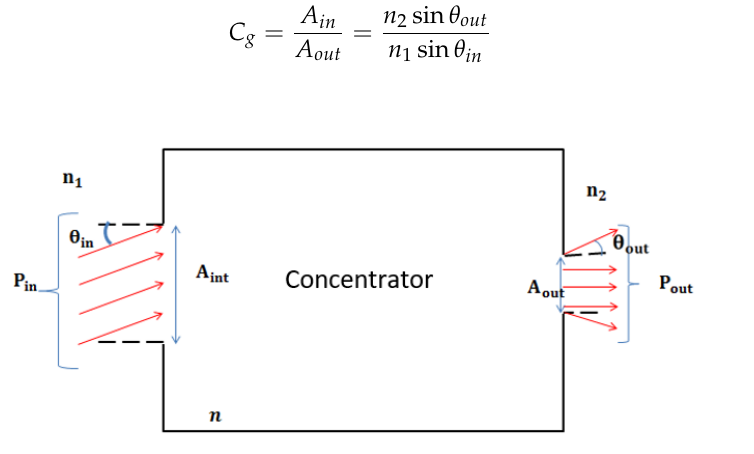
Figure 2. General view of an optical